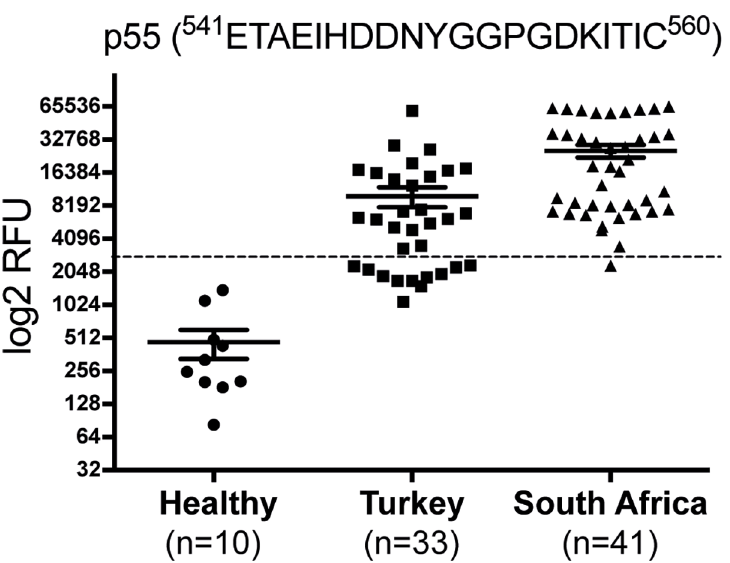
Fig 5. Dot-plot of intensities of the selected peptide 55 ( 541 ETAEIHDDNYGGPGDKITIC 560 ) after serology. This included sera from Turkish CCHFV survivors, control sera from individuals infected with other viral pathogens as controls and Bulgarian indivduals vaccinated against CCHFV. The dotted line represents the diagnostic cut-off value. P < 0.0001. https://doi.org/10.1371/journal.pntd.0006598.g005 amino acid sequences for each peptide region were retrieved from UniProt and aligned to identify similarities between the geographically distinct isolates of the virus (Table 3). This high coverage of same peptide reactivity can be explained by high amino acid conservation along the selected epitopes (Table 3). In contrast the alignment confirms up to four mis- matches in the predicted amino acid sequence between the Turkish peptide sequence and the